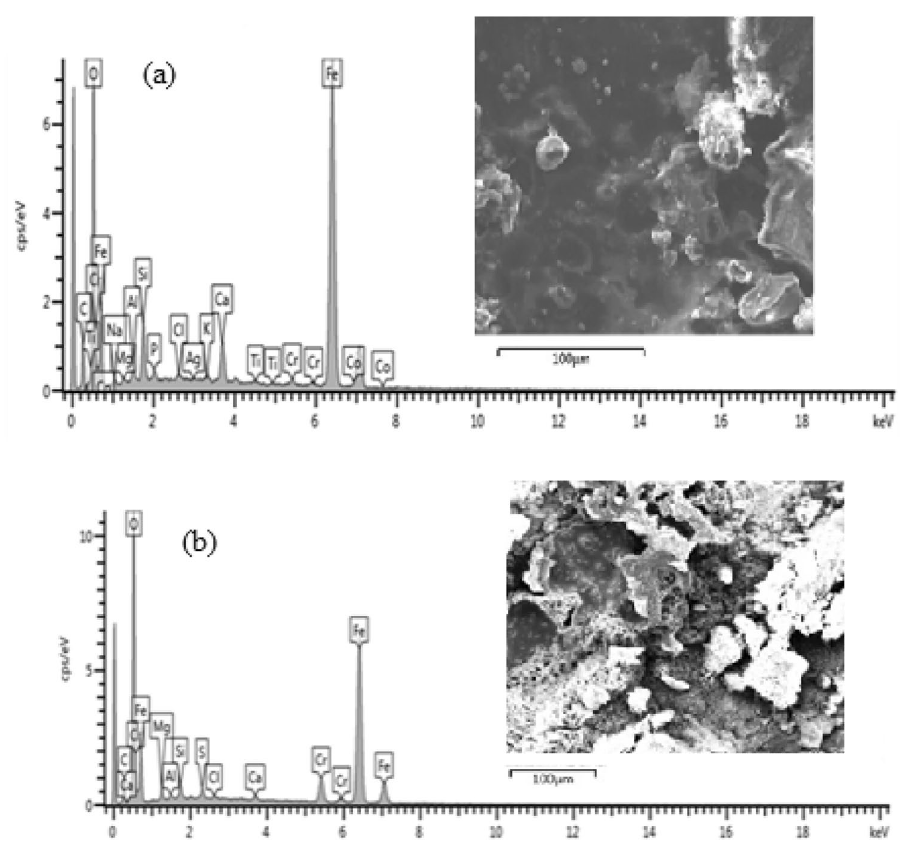
Figure 17. Energy diffraction spectron (EDS) of sample heated at 200 °C: ( a ) before corrosion and ( b ) after